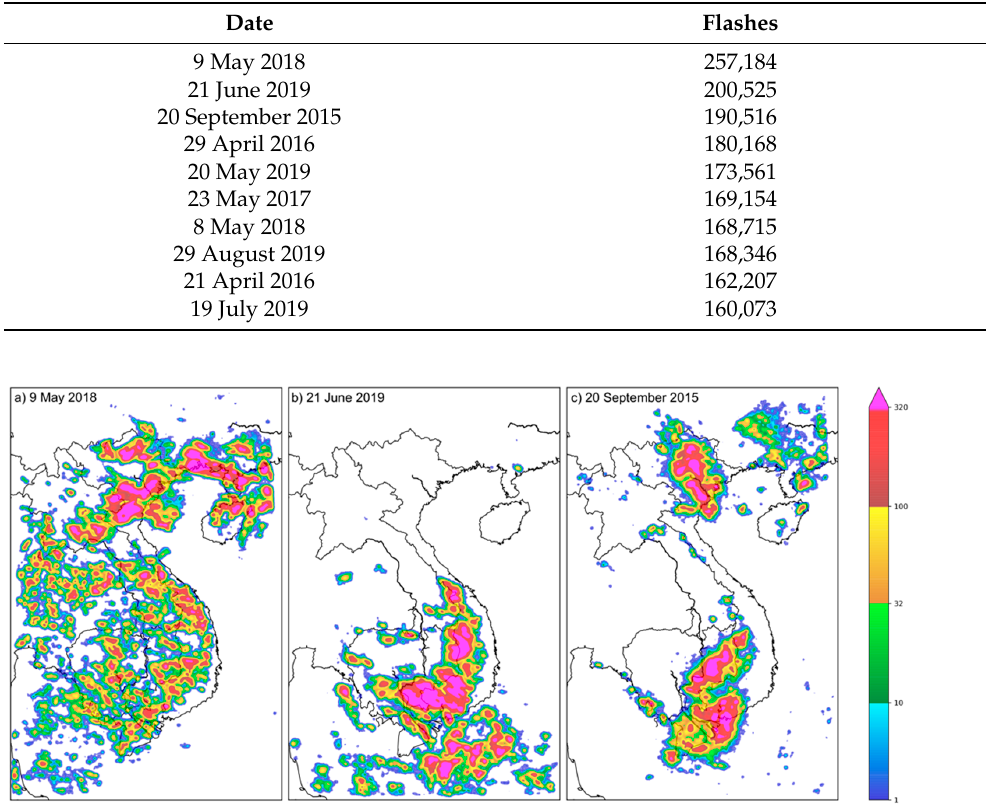
Table 1. The ten most lightning-abundant days in Vietnam in 2015–2019.